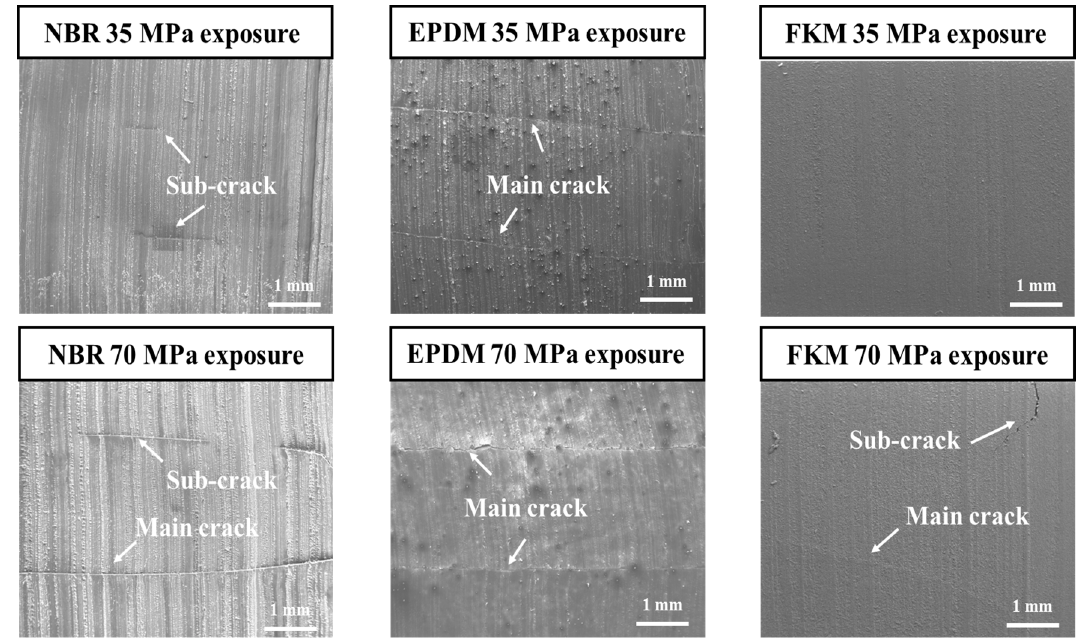
Figure 7. SEM images of compression set for NBR, EPDM, and FKM exposed to 35 and 70 MPa hydrogen pressure.